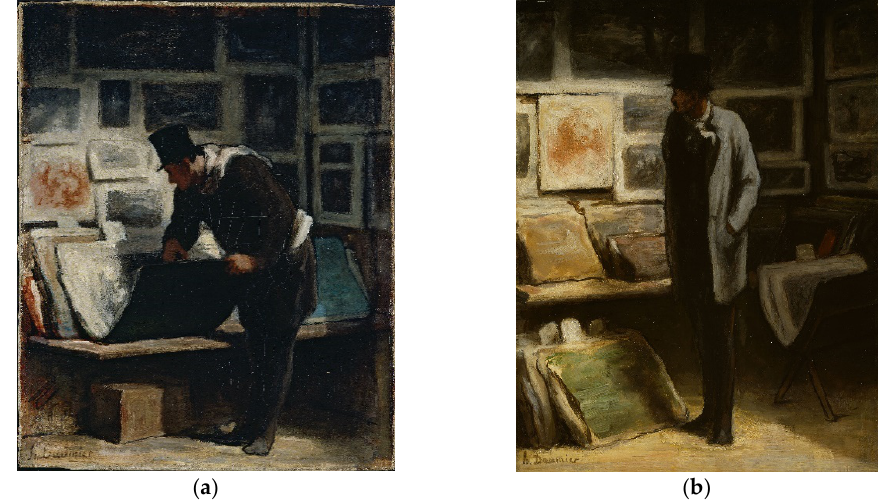
Figure 6 ( a ) A. Daumier. The Stamp Lover. 1856–1860 Musée des Beaux-Arts de la Ville de Paris . Figure 6. ( a ) A. Daumier. The Stamp Lover. 1856–1860 Mus é e des Beaux-Arts de la Ville de Paris. ( b ) A. Daumier. The Stamp Lover. 1856–1860 The Art Institute of Chicago. ( b ) A. Daumier. The Stamp Lover. 1856–1860 The Art Institute of